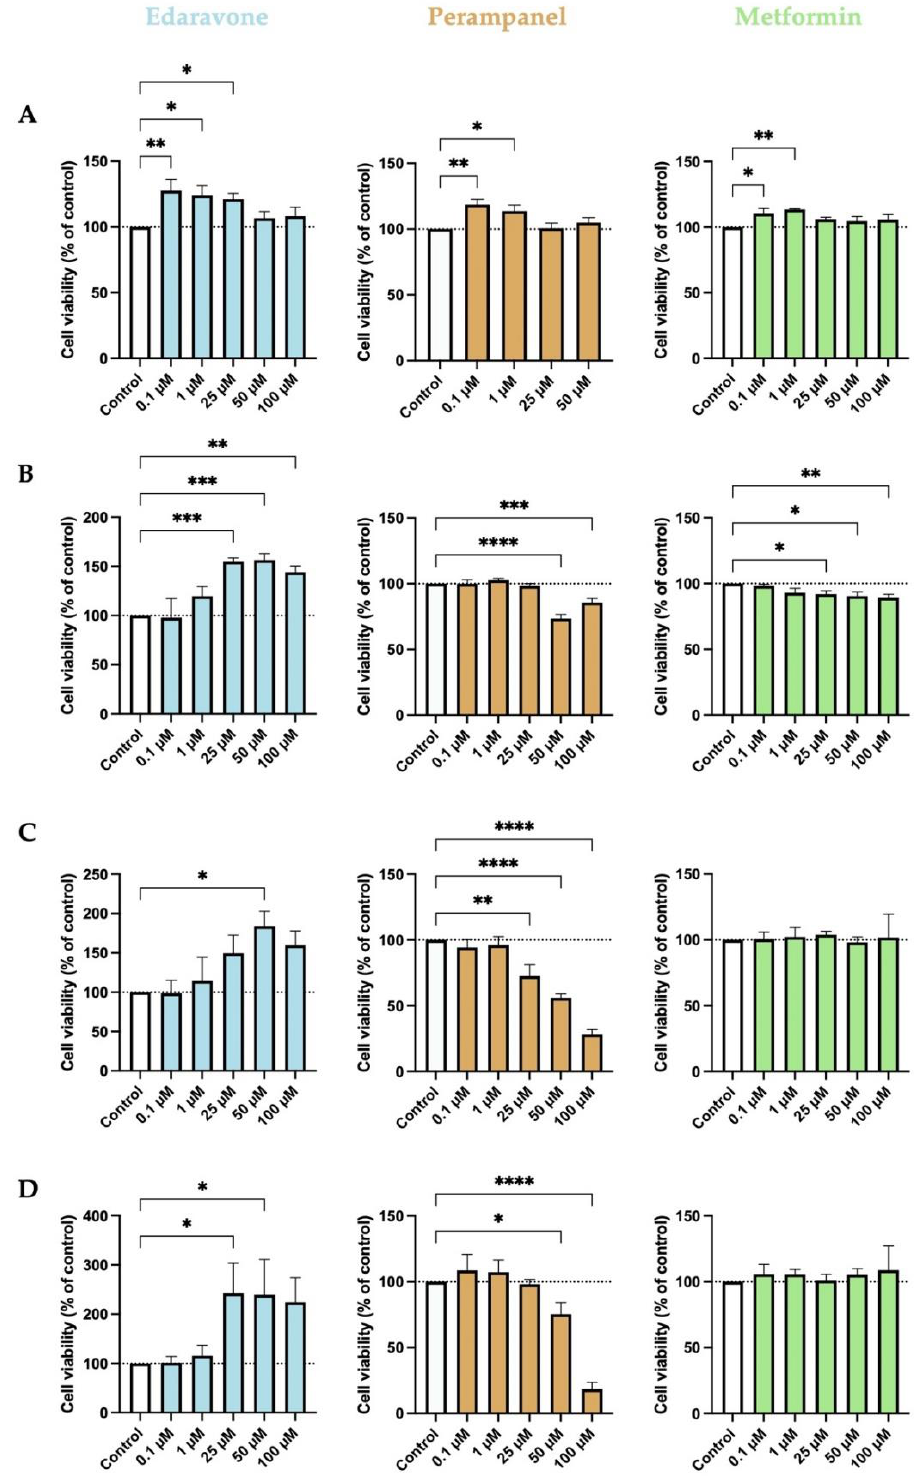
Figure 1. Effects of edaravone, perampanel, and metformin on the viability of HT-22 cells, at different time points of exposure. ( A ) 6-h treatment; ( B ) 24-h treatment; ( C ) 48-h treatment; ( D ) 72-h treatment. Cell viability was assessed by using the MTT assay. Results are expressed as the percentage of cell viability relative to the respective untreated control cells. *, **, ***, and **** indicate p < 0.05, p < 0.01, p < 0.001, and p < 0.0001, respectively, when compared to control. All data are presented as the mean + SEM of three independent